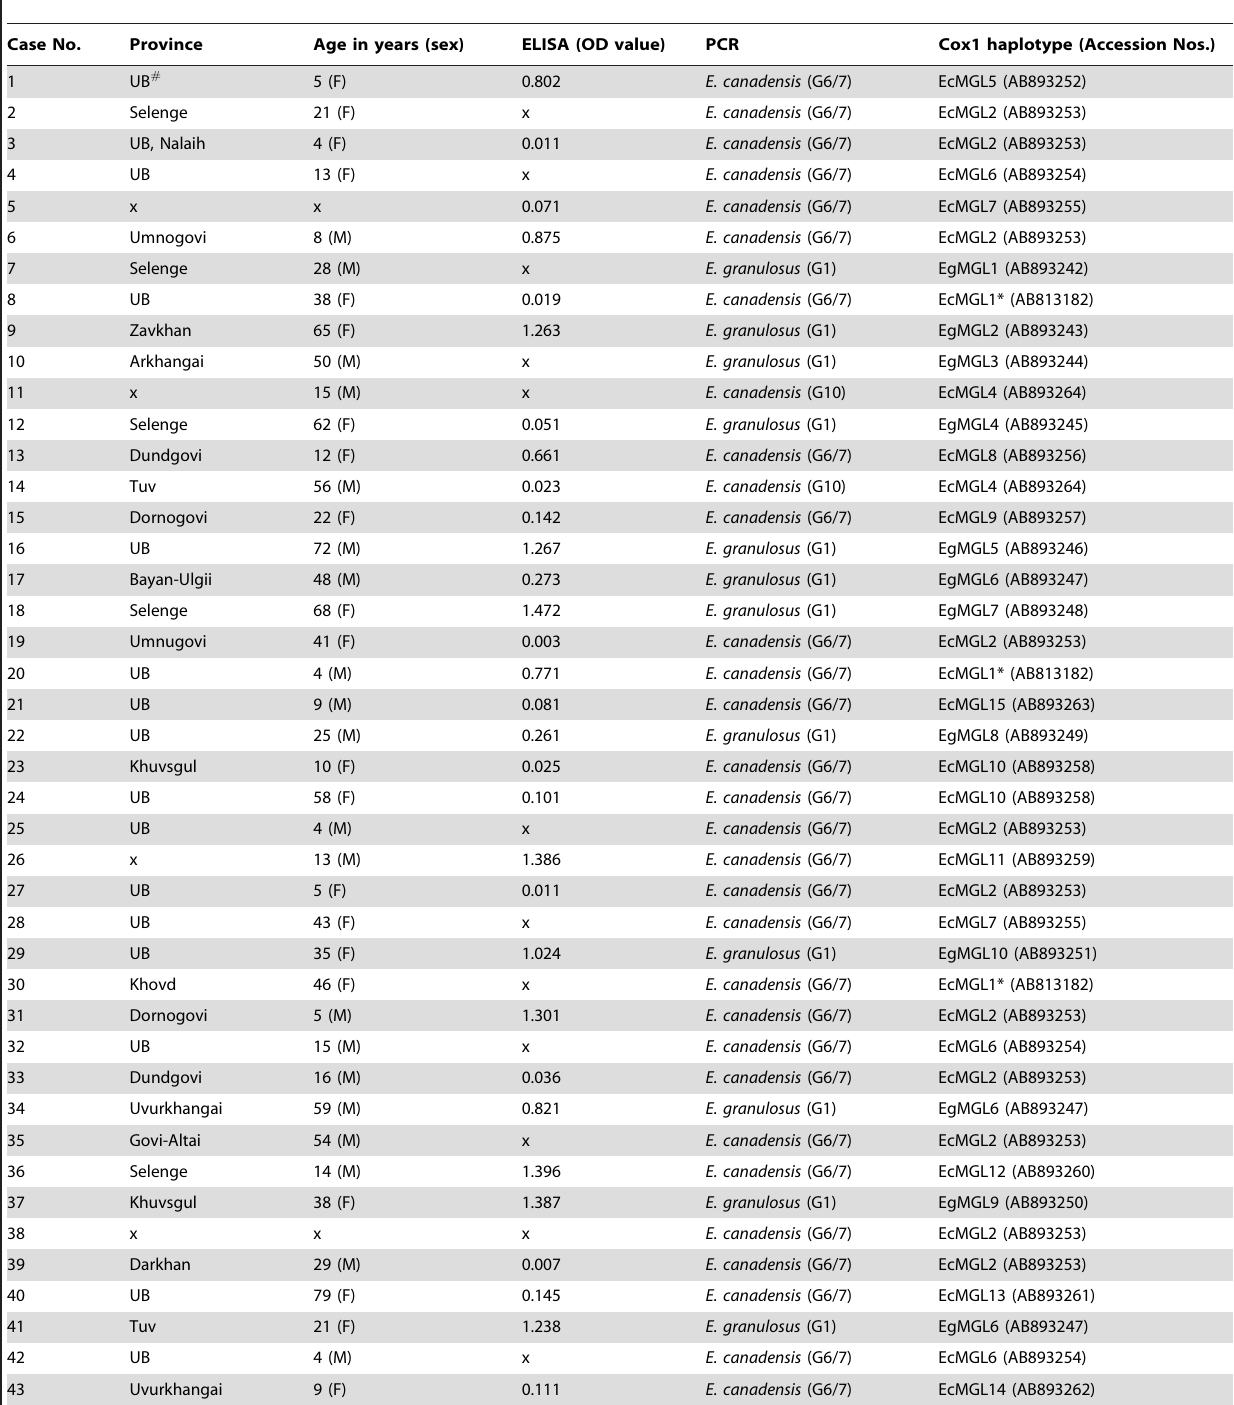
Table 1. Molecular identification of the causative species of 43 CE cases and antibody response to rAgB in ELISA (n= 31, cut-off value: